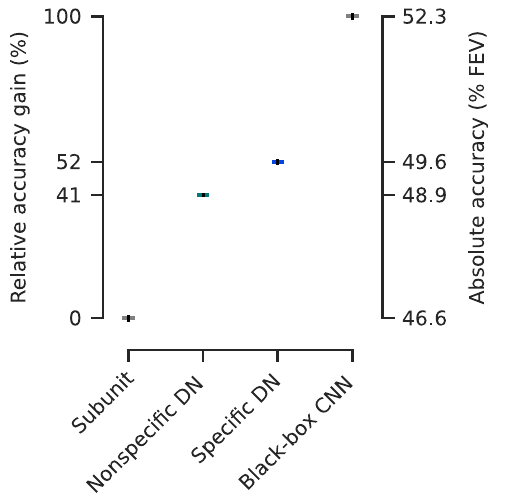
Fig 3. Performance comparison of our models fitted to the data from Cadena and colleagues [14] relative to the gap between the best shallow model—a subunit one layer convolutional neural network (CNN)—and the deeper data-driven state-of-the-art three-layer CNN [14]. Non-specific divisive normalization (DN) accounts for 41% of this gap, while specific DN improves it up to 52%. Absolute values in terms of percentage of explainable variance explained (FEV) on the right (mean over the ten best models selected in terms of validation set accuracy, see main text for details). Error-bars (black) indicate the standard error of the mean. Model performance is significantly different between each model class (pairwise Wilcoxon signed rank test on best models in terms of validation accuracy: p < 0.024, N = 166 neurons, family-wise error rate α = 0.05 using Holm-Bonferroni correction).